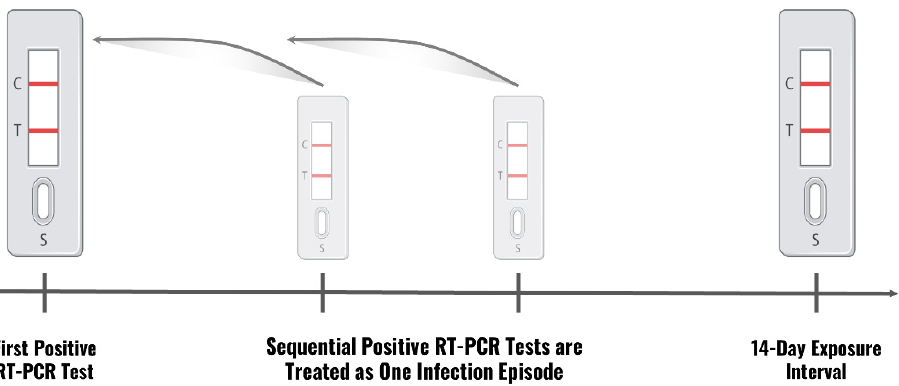
Figure 1. Representation of an Individual Positive Event. The pivotal event was considered the first positive reverse transcription polymerase chain reaction (RT-PCR) test for an individual (left test illustration), and each positive test in the following 14-day period (light test illustrations) was treated as the same infection event.